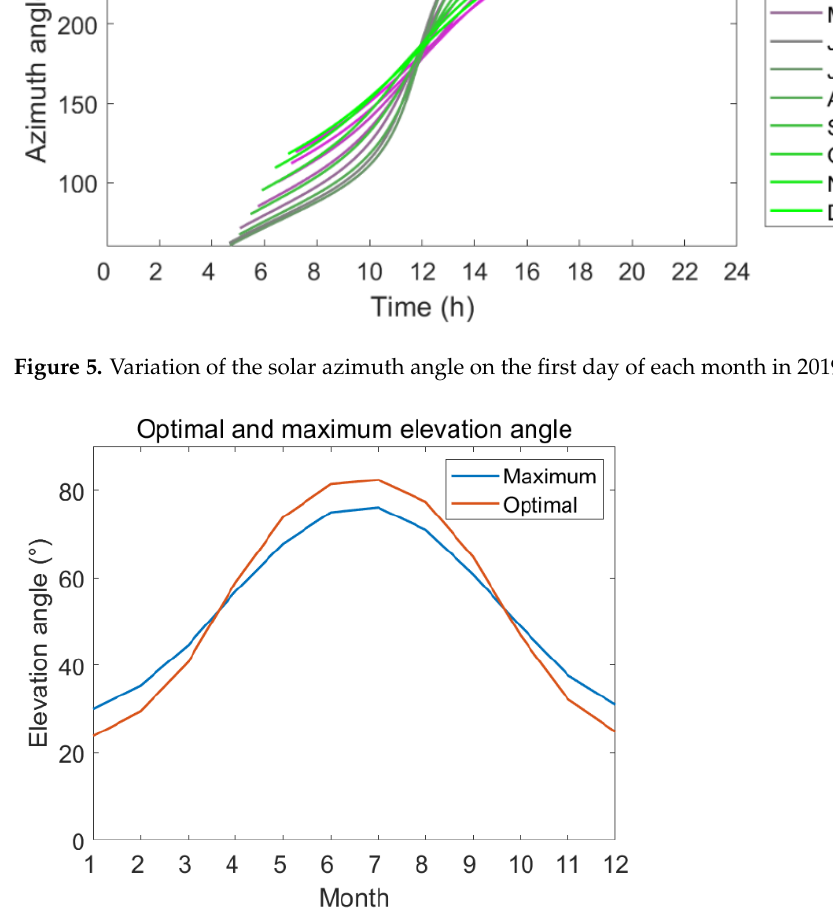
Figure 6. The optimal tilt and maximum elevation angles for 2019 vary with the month. The horizontal coordinates indicate the month, and the vertical coordinates indicate the elevation angle. The locations are 37 ◦ N and 122 ◦ E. The two lines indicate the optimal tilt angle (optimum) and the altitude angle at solar noon (maximum), respectively.